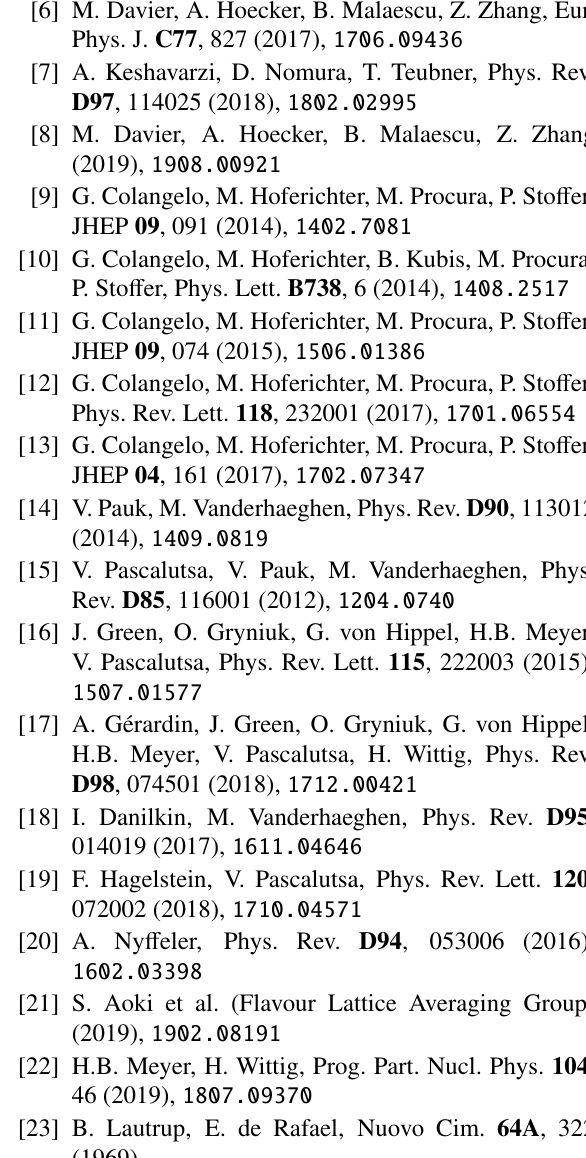
most panel of Fig. 8. The latter corresponds to the di ff er- ence between the experimental result for a µ and the SM prediction without the leading-order HVP